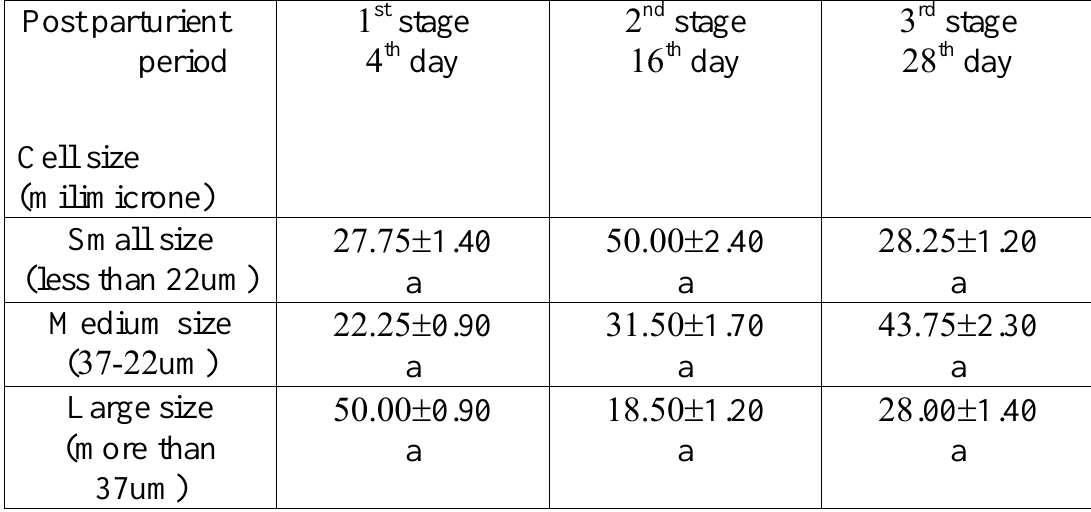
Table 1: Size of vaginal epithelial cells during post parturient periods in Awassi ewes (n=12).